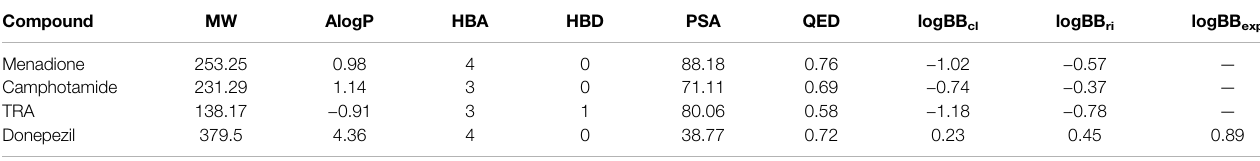
TABLE 3 | Summary of molecular descriptors and partitioning coef fi cients ( logBB ) determined for lead compounds (drugs) with highest A β inhibition properties.